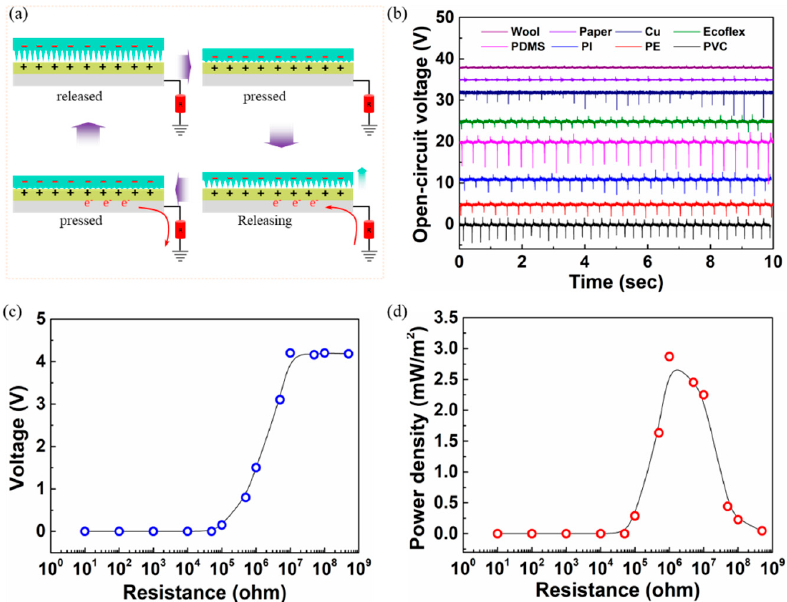
Figure 4. Bio-TENG pressure sensor device structure and characteristics. ( a ) Schematic representation of the TENG pressure sensor under various applied pressures and released conditions. ( b ) The open-circuit voltage output of the bio-TENG device with different positive and negative materials upon contact and release cycling. ( c , d ) Output voltage and power density at various load resistances.